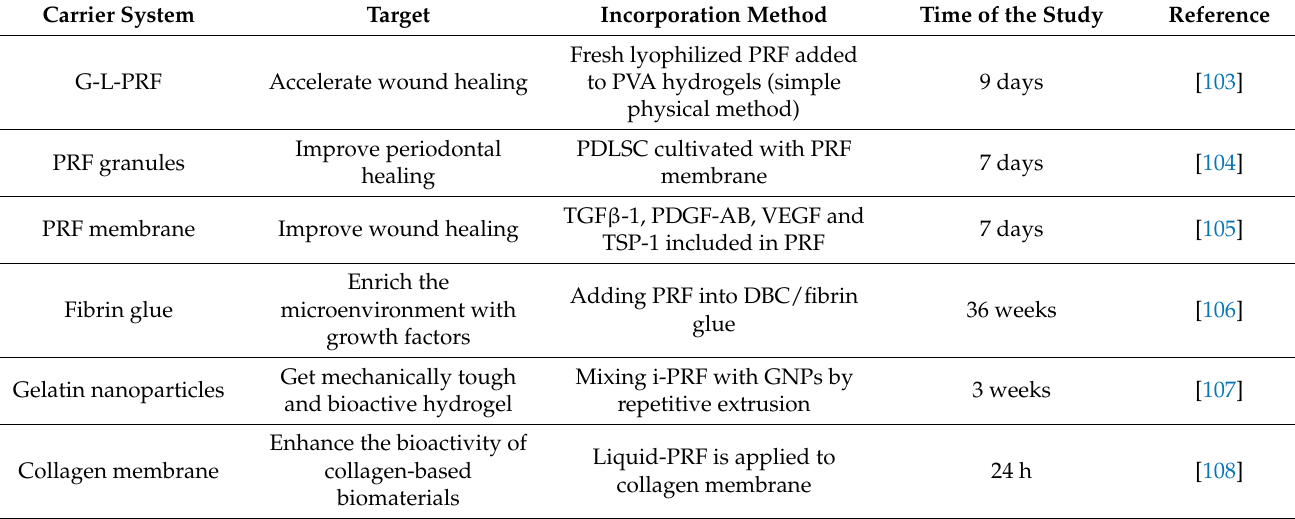
Table 5. Carrier systems incorporated in injectable platelet-rich fibrin.